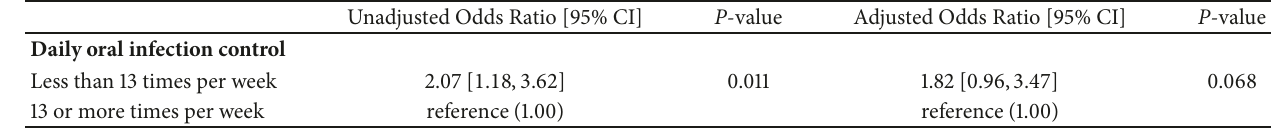
Table 3: Logistic regressions on low